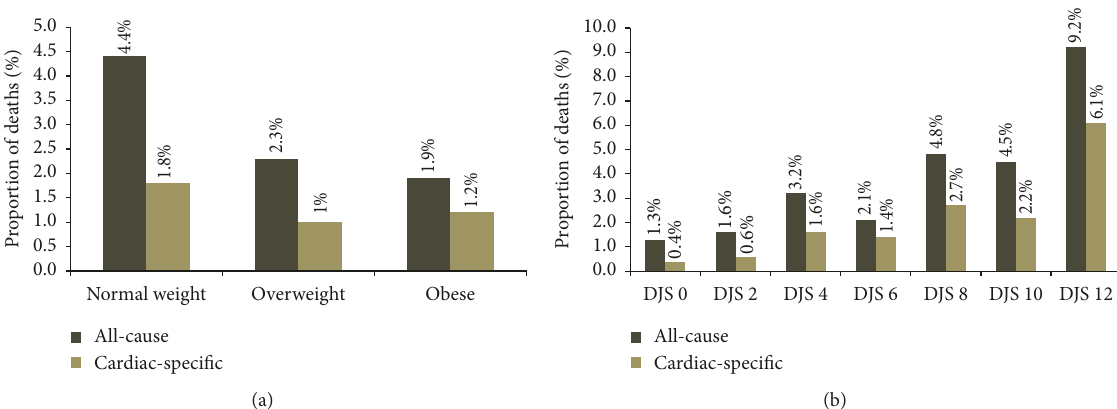
Figure 1: (a) Unadjusted 1-year all-cause and cardiac-specific mortality according to BMI. (b) Unadjusted 1-year all-cause and cardiac-specific mortality according to Duke Jeopardy